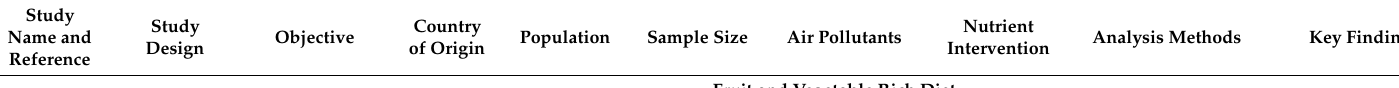
Table 1. Characteristics of the included